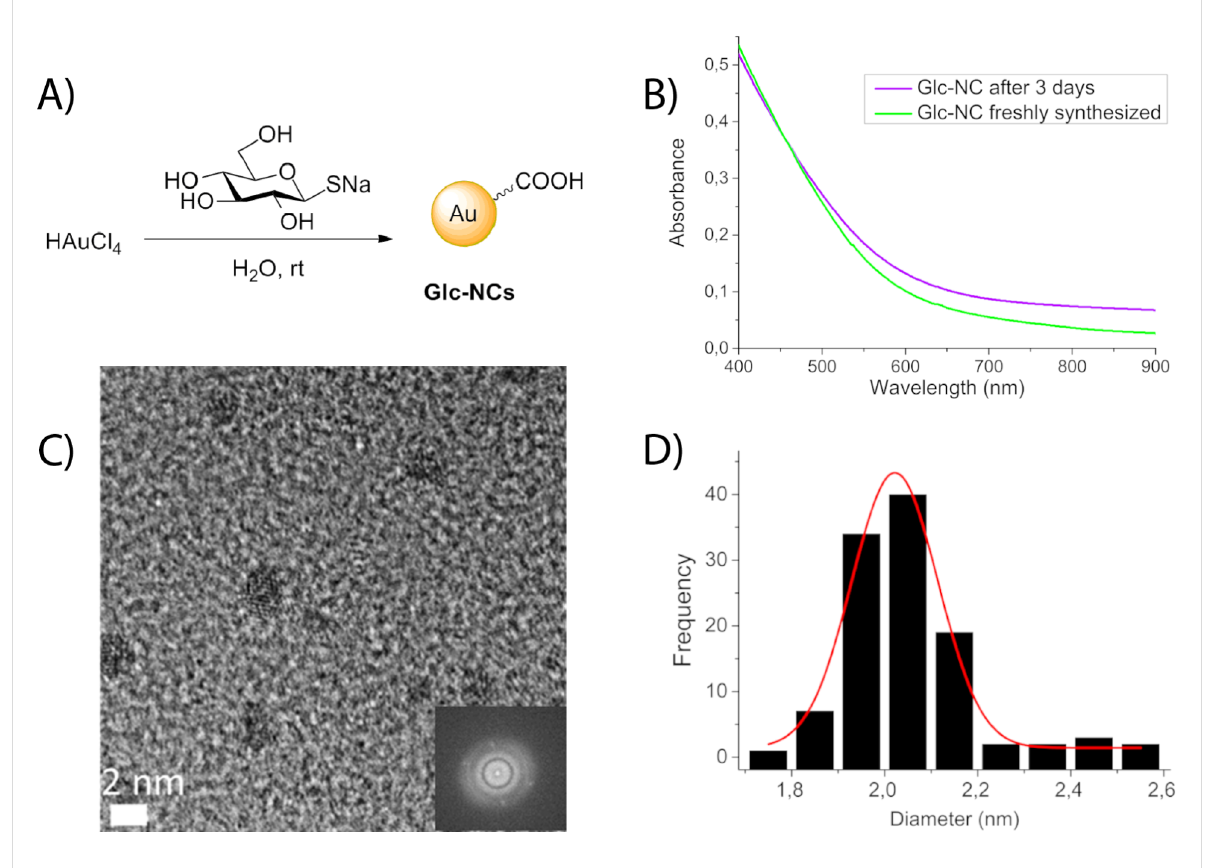
Figure 1: A) One-pot synthesis of Glc-NCs at room temperature; B) UV–vis spectra of freshly synthesized Glc-NCs and after three days are indica- tive of stable particles; C) high-resolution TEM bright-field image of Glc-NCs showing monodisperse nanoclusters, scale bar 2 nm; D) size distribu- tion of 110 nanoclusters of Glc-NCs yielding diameters of 2.02 ± 0.18